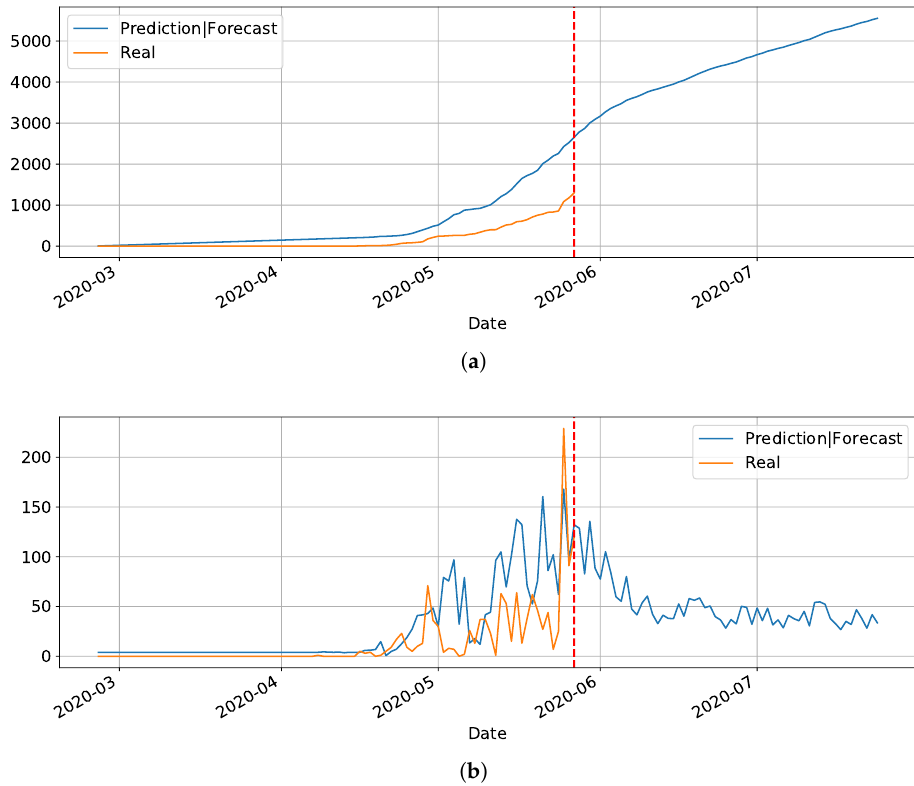
Figure 10. Predictions and forecasting to RN on Covid-19 cumulative ( a ) and daily ( b